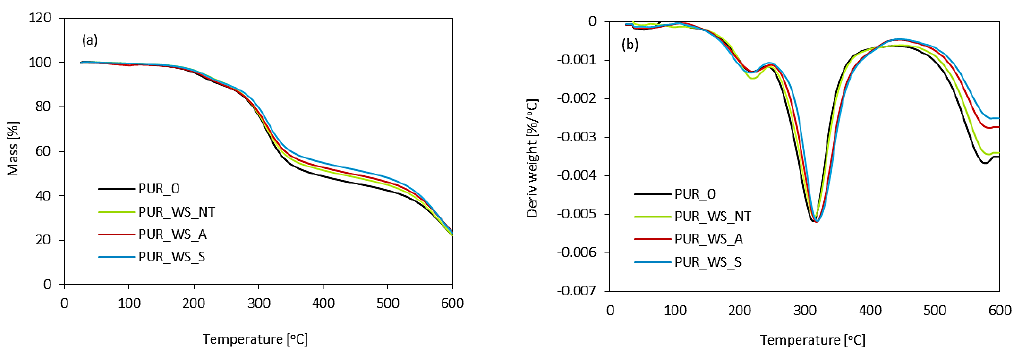
Figure 9. ( a ) TG and ( b ) differential thermogravimetry (DTG) curves obtained for PUR foams.